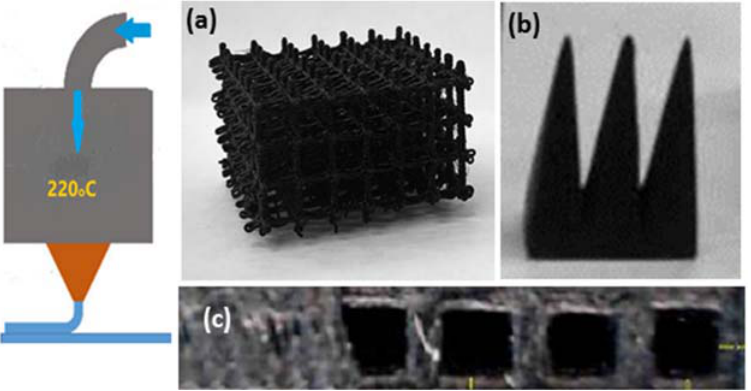
Figure 8. 3D printed complex structures, at 220 °C, nozzle D = 0.5 mm using hybrid nanocomposite filaments: ( a ) 1.5 wt.% GNP/PLA; ( b ) 1.5 wt.% MWCNT/PLA; and ( c ) 9 wt.% GNP/PLA.